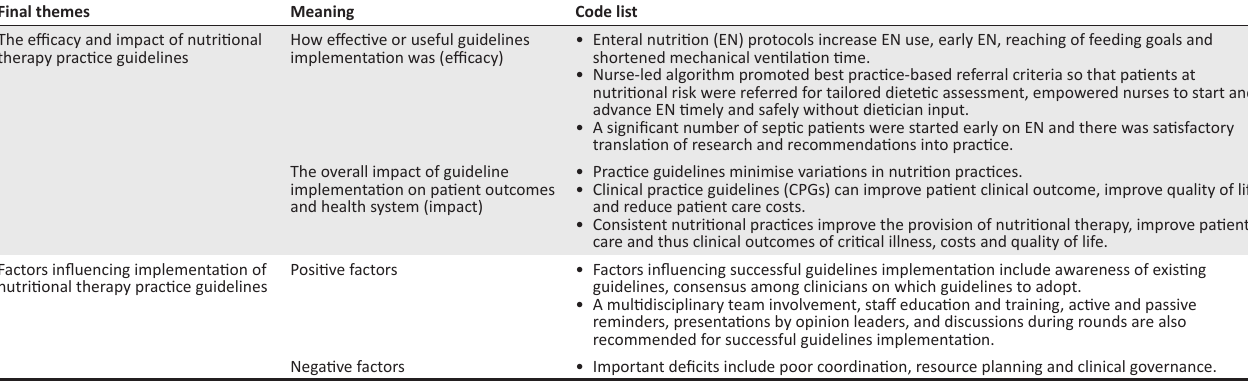
FIGURE 2: Summarised focus of included studies. TABLE 7: Themes generated from thematic analysis of